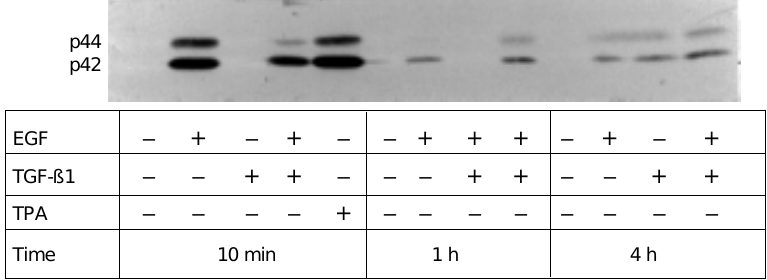
Figure 2 - Effect of TGF-ß1 on epidermal growth factor (EGF)-induced p42/p44 MAPK activa- tion. Postconfluent, quiescent C3H 10T1/2 cells were switched to DMEM containing 0.1% FBS 24 h prior to T = 0 h when 20 ng/ml EGF or 5 ng/ml TGF-ß1 or 1 µM tetradecanoyl- phorbol acetate (TPA) was added. At the indicated times, whole cell extracts were prepared, subjected to SDS-PAGE on 12% gels, and transferred to nitrocellulose (14). Western blotting analysis was performed by probing the blots with a polyclonal antibody to the active, dually phosphorylated p42/p44 MAPK obtained from Promega